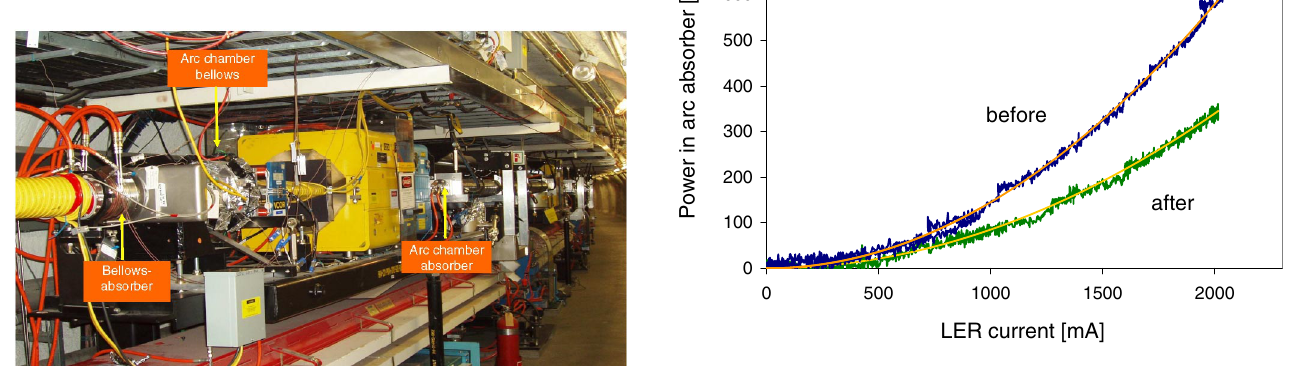
FIG. 16. (Color) HOM power in the downstream arc absorber before (dark blue) and after (green) the installation of the bellows absorber. Orange and yellow lines show a quadratic fit.